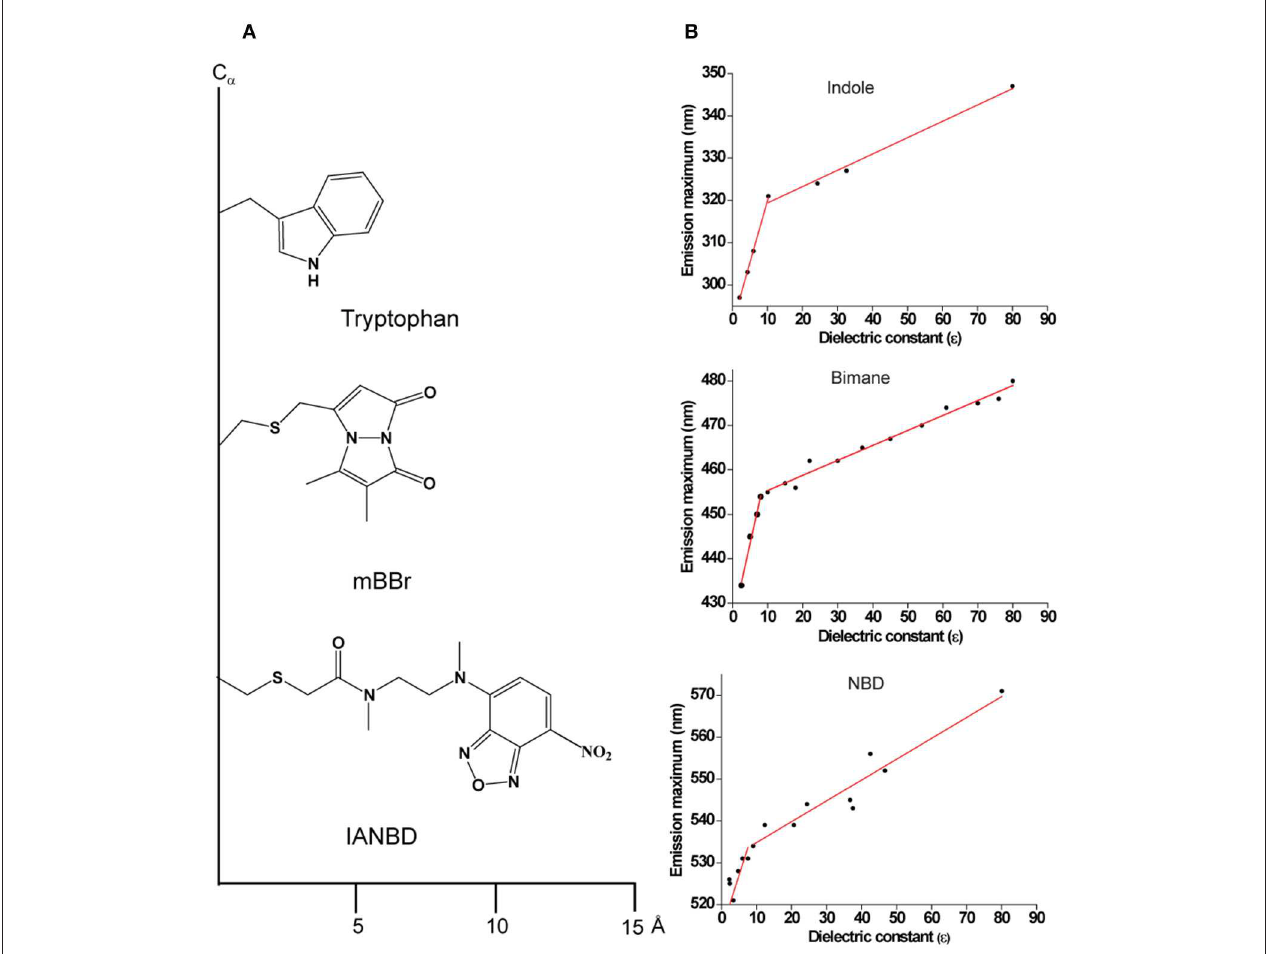
FIGURE 3 | (A) Schematic representations of Tryptophan; monobromobimane (mBBr) and N , N ′ -Dimethyl- N -(iodoacetyl)- N ′ -(7-nitrobenz-2-oxa-1,3-diazol-4-yl) (IANBD) showing their size from the point of attachment to the C α − protein backbone. (B) Environment-sensitivity of widely used fluorescent probes. A plot of emission maximum as a function of dielectric constant is shown for the widely used intrinsic fluorophore of a protein, Trp (indole as the fluorescing group) and for the popular extrinsic probes for site-directed fluorescence, NBD and bimane. Data are adapted from Sun and Song (1977) (indole); Fery-Forgues et al. (1993) (NBD); Ho et al. (2013) (bimane) and plotted. See text for